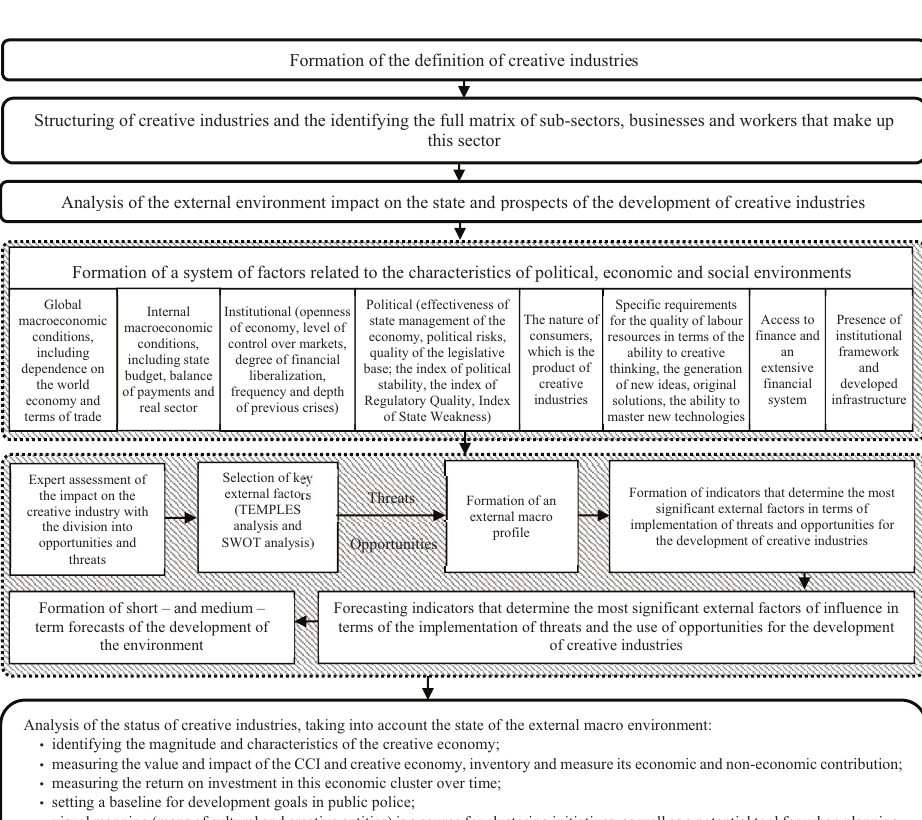
Figure 5. Directions of analysis in the context of developing a state policy for the development of creative industries (source: created by